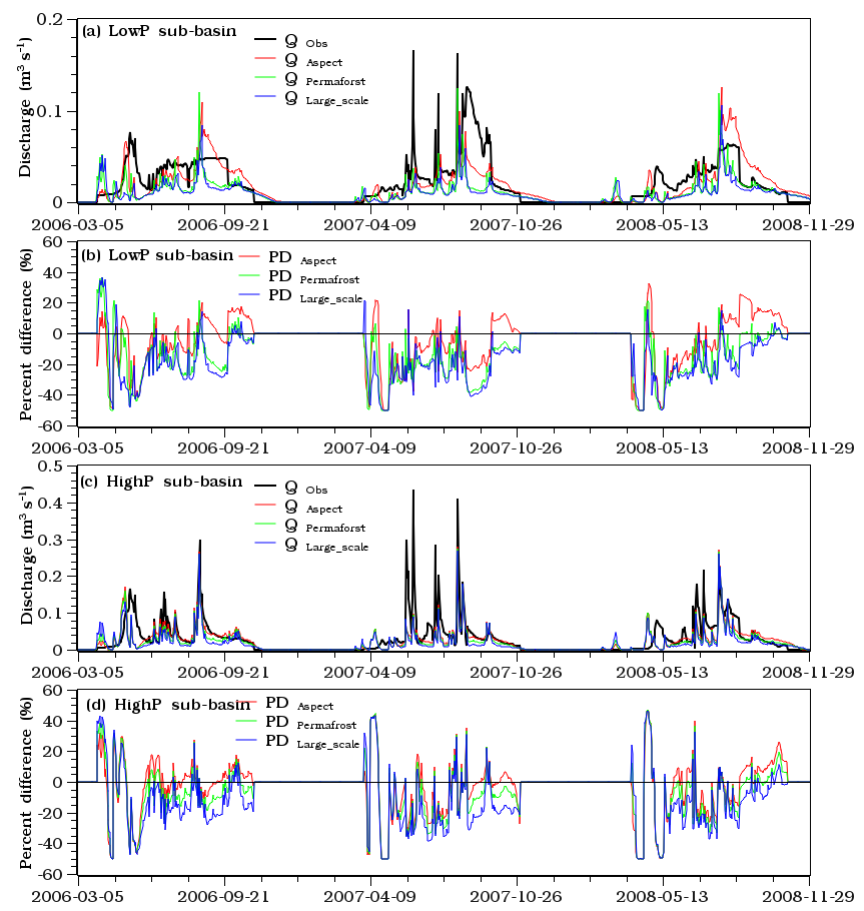
Figure 6. Comparison of streamflow simulations – obtained from different parameterizations – with observations (a) in the LowP sub-basin and (c) in the HighP sub-basin. Panels (b) and (d) show the percent difference (PD) for each runoff simulation from the observed streamflow in the LowP and HighP sub-basins,